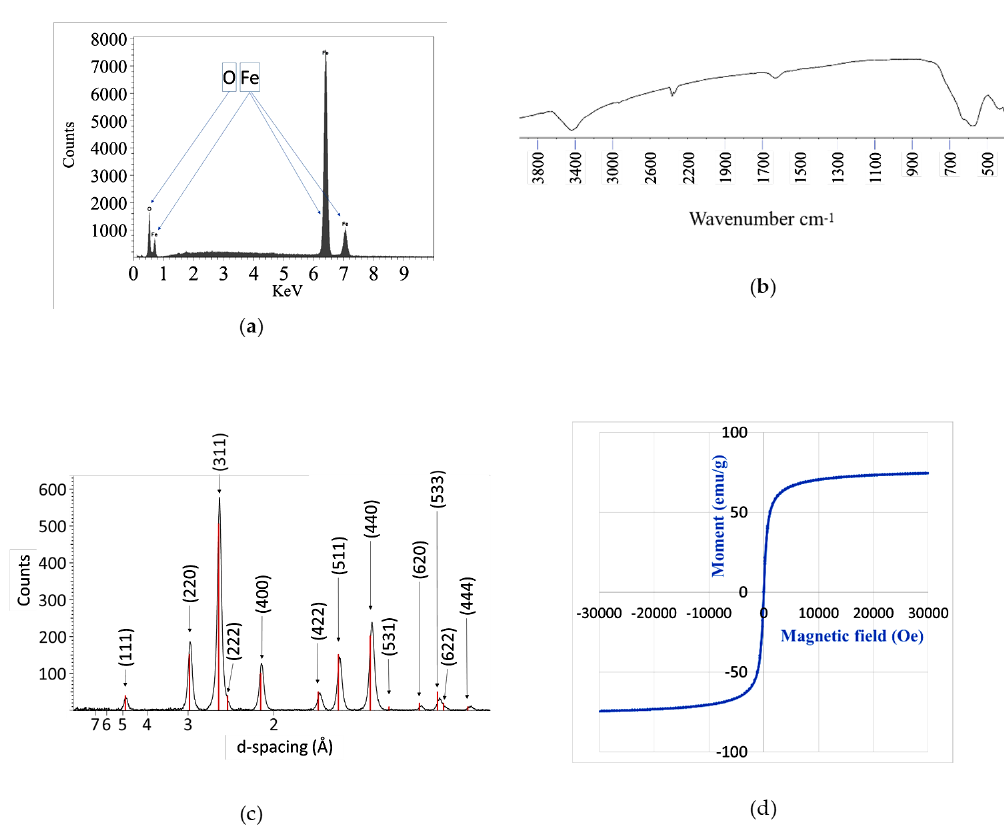
Figure 7. Analysis of powdered synthesized nanoparticles by: ( a ) energy dispersive X-ray fluorescence (EDXRF); ( b ) Fourier transform infrared spectroscopy (FTIR); ( c ) X-ray diffraction (XRD) with overlay from reference library in red; ( d ) magnetization saturation.